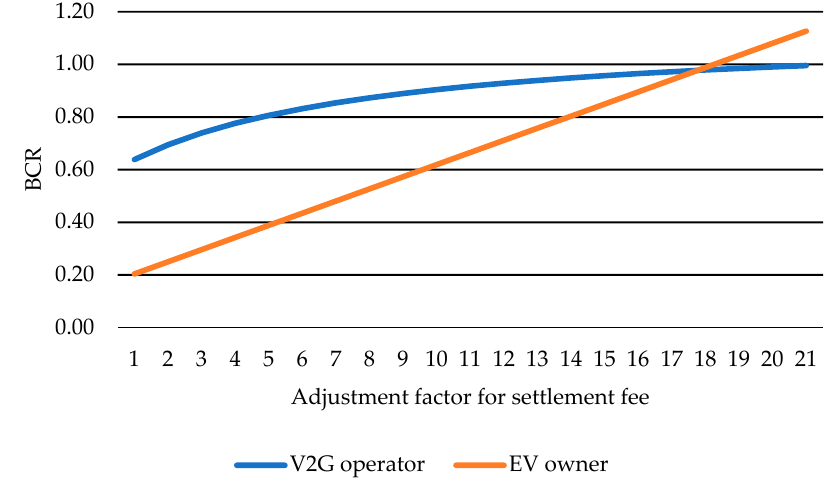
Figure 8. V2G-service operator and EV owner BCRs with AC chargers.